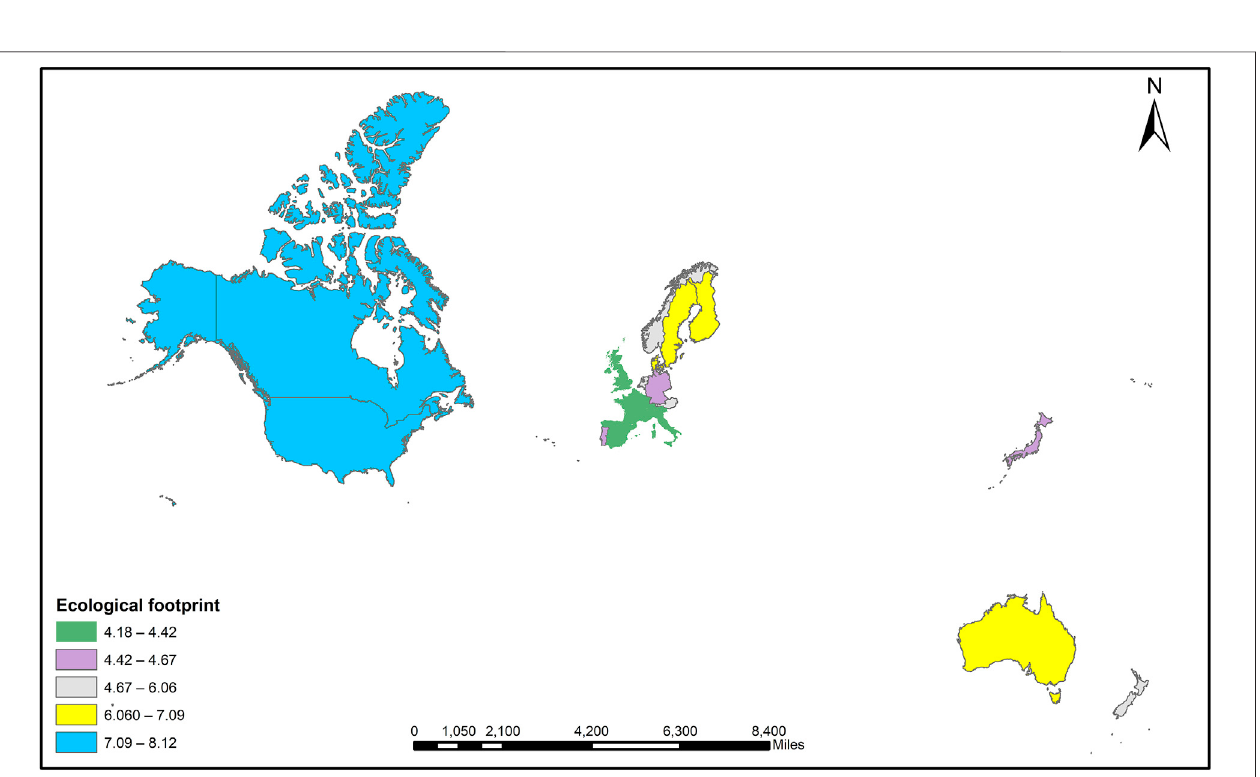
FIGURE 2 | Spatial distributions of ecological footprint per capita in 2018. Data Source: GFN (2021).